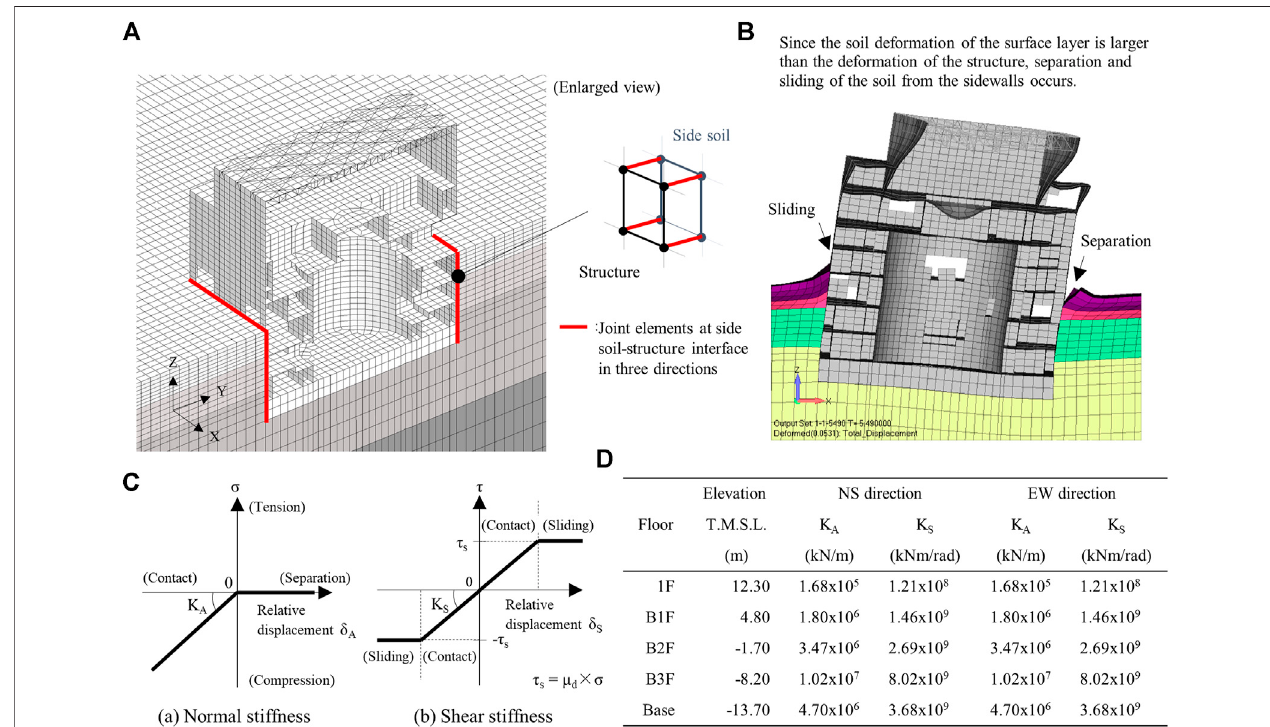
FIGURE 7 | Depiction of SSI model. (A) Joint elements at soil-structure interface. (B) Response characteristics of nonlinear SSI of the separation and sliding of soil fromsidewallsbyjointelements. (C) Nonlinearpropertiesofjointelements. (D) SpringconstantsofsidesoilfromB3Fto1FlevelobtainedfromthemethodbyNovaketal.